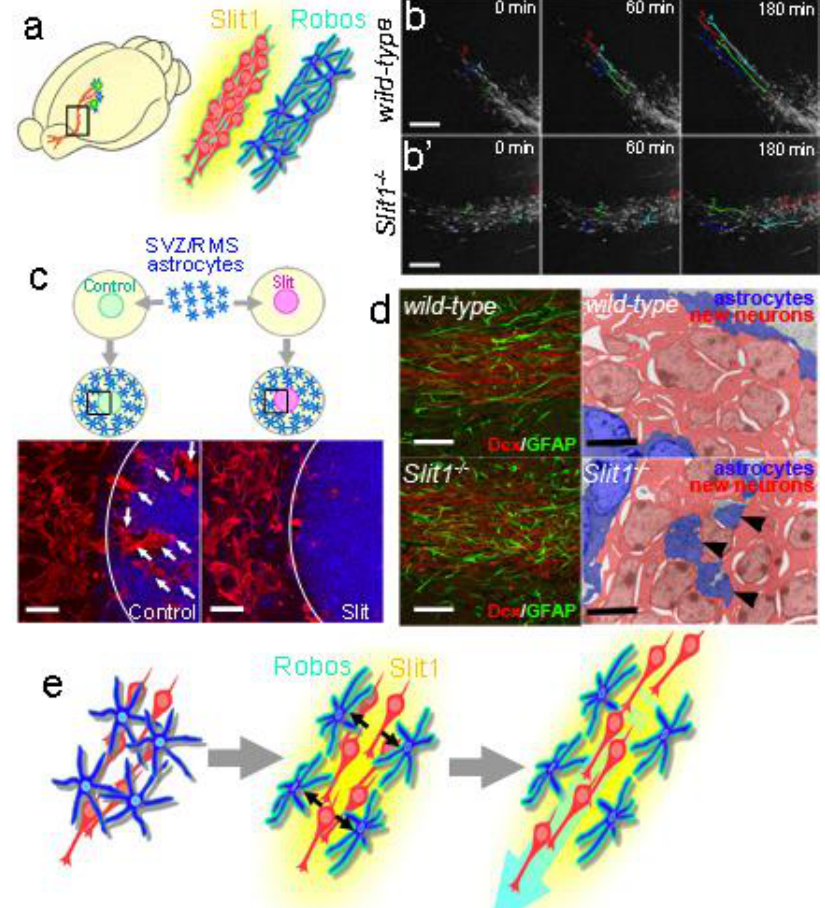
Figure 4. Interaction between migrating new neurons and the surrounding astrocytes. (modified from Kaneko et al ., Neuron, 2010 [76]). ( a ) Expression patterns of Slit1 and Robos in the RMS; ( b ) Disrupted migration of new neurons in a Slit1-defficient ( Slit1 −/− ) brain slice. Representative paths of new neurons migrating in cultured brain slices obtained by time-lapse imaging were drawn with colored dots and lines. Compared with those of the wild-type (top) slice, the migration of new neurons in the Slit1 −/− RMS was irregular and slower (bottom, b’). Scale bars: 200 μm; ( c ) Slit repels SVZ/RMS astrocytes. Purified astrocytes dissociated from the SVZ and RMS were co-cultured with either Slit-expressing or control HEK cells mixed into collagen gel pieces (top). After 4 days of co-culture, significantly fewer astrocytes stained with GFAP (red) were observed on the Slit-containing gel (bottom right) compared with the control gel (bottom left). Scale bars: 200 μm; ( d ) Disruption of astrocytic tunnels in the Slit1 −/− RMS. Sagittal brain sections containing wild-type or Slit1 −/− RMS were immunostained with Dcx and GFAP (left). In the wild-type RMS, GFAP+ (green) astrocytic processes were extended along the chains of new neurons (red), whereas in the Slit1 −/− RMS, the arrangement of astrocytic processes was irregular. Electron micrographs (right) reveal an abnormal distribution of astrocytic processes (arrowheads) among the chain-forming new neurons in the Slit1 −/− RMS. Scale bars: 50 μm (white); 5 μm (black); ( e ) Schematic drawings of the Slit-Robo-mediated interaction between new neurons and tunnel-forming astrocytes. The new neuron-secreted Slit1 and astrocyte-expressed Robo receptor control the distribution and arrangement of astrocytes to maintain the migratory path of new neurons, which assists their rapid migration through the